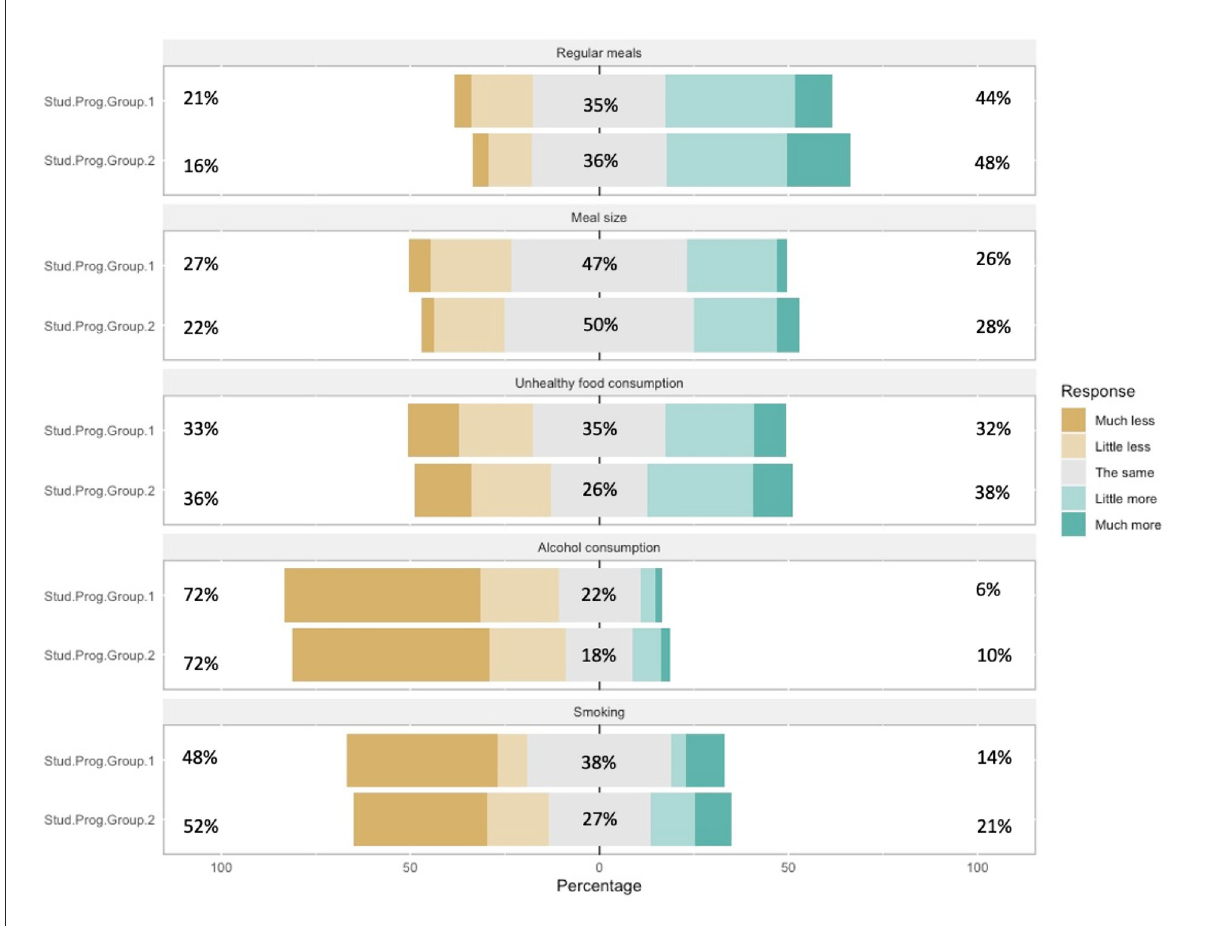
FIGURE2 Changes in eating habits and other habits – male